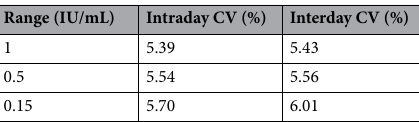
Table 4. Intra-day and inter-day precision for the analytical method. CV coefficient of variation.